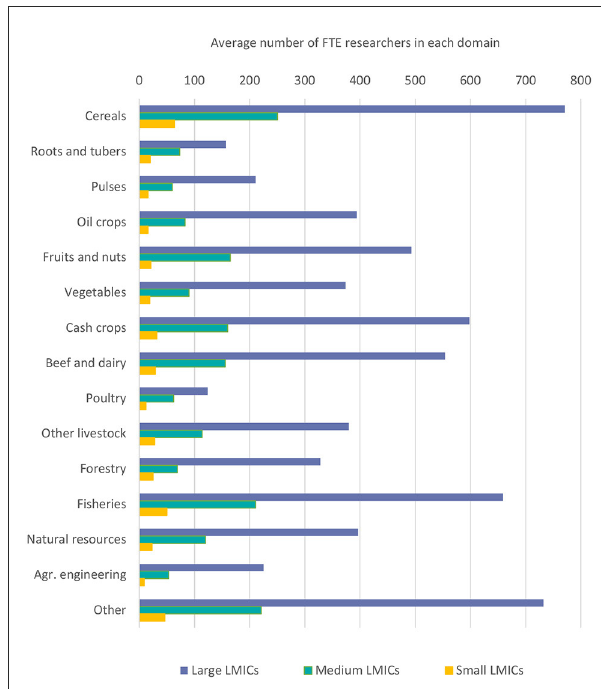
FIGURE8 Average number of FTE researchers allocated to different research activities in LMICs with large, medium, and small agricultural research system, 2011–2016. Source: Elaborated by authors based on Agricultural Science and Technology Indicators